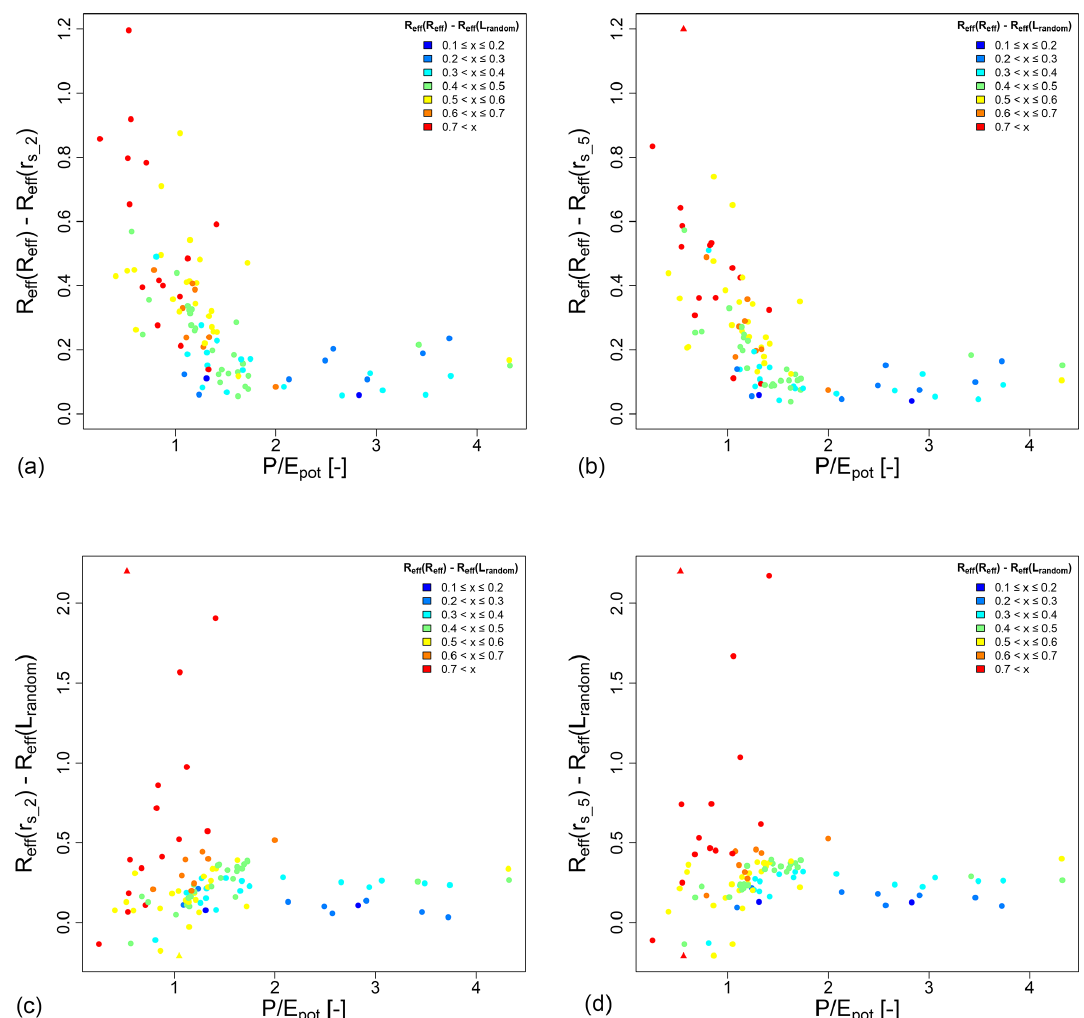
Figure 4. Difference in model validation results (model efficiency) for the models calibrated with data from two ( r s_2 ; left) and five ( r s_5 ; right) stream level classes and the upper benchmark ( R eff ; upper row) and the lower benchmark ( L random ; bottom row) as a function of the aridity index ( P/E pot ). Each dot represents one catchment; the colour of the symbol represents the difference in model efficiency between the upper and lower benchmarks for that catchment. Note the difference in the scale of the y axis for the comparison to the upper benchmark (upper row; a and b ) and the lower benchmark (lower row; c and d ). Triangles indicate outliers that would plot outside the range of the y